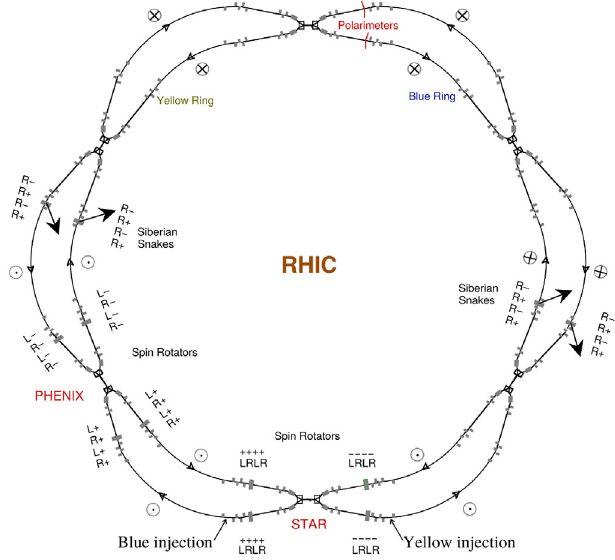
FIG. 2. R þ R − R þ R − and R − R þ R − R þ four-helix snakes in RHIC Blue and Yellow rings, at 9 o ’ clock and 3 o ’ clock. The beam goes clockwise in Blue, counterclockwise in Yellow.